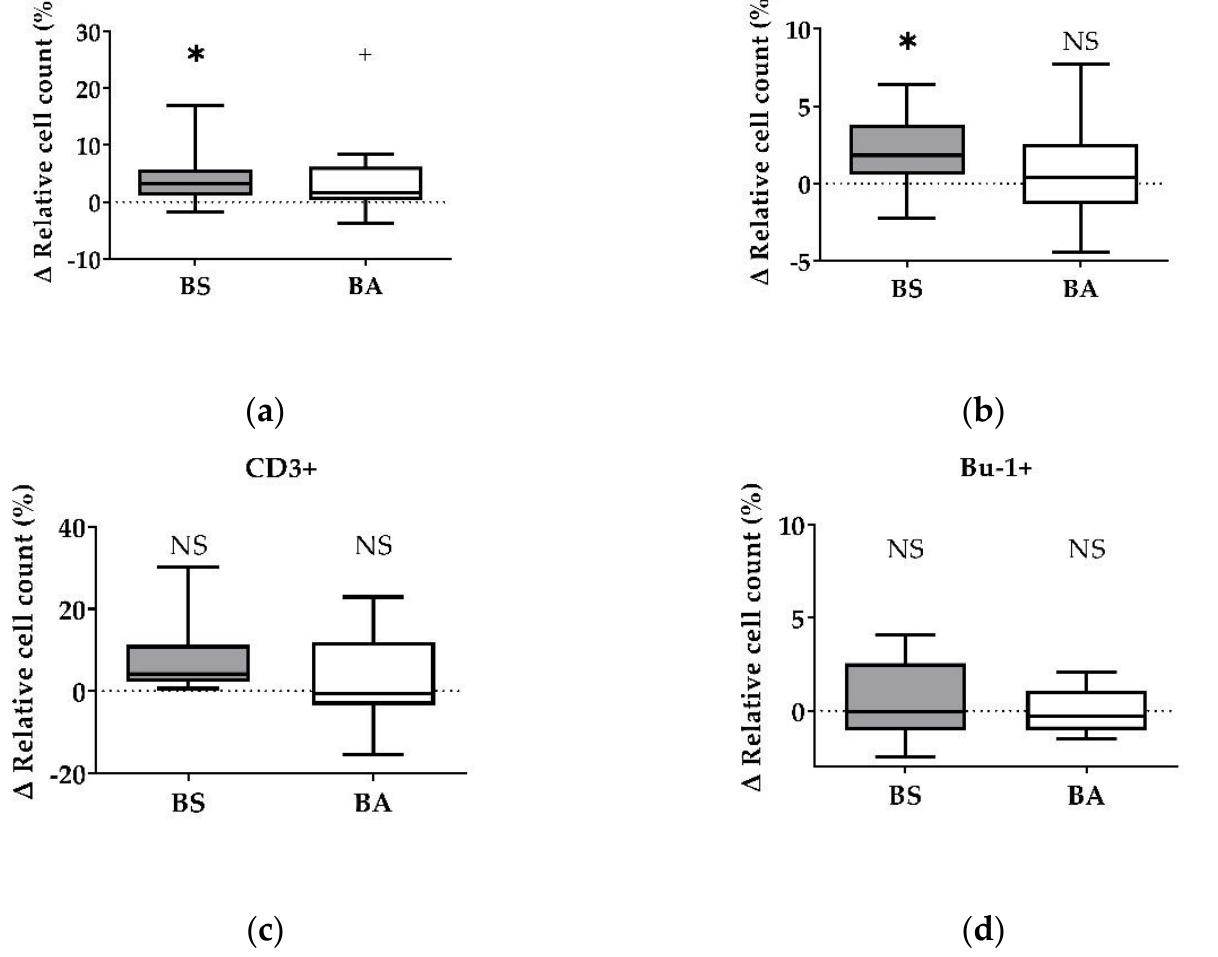
Figure 1. Influence of vital B. subtilis DSM 32315 (grey) and B. amyloliquefaciens CECT 5940 (white) on the proliferation of T and B cells. Isolated PBMCs were treated with BS or BA in a ratio of 1:3 (PBMCs: Bacillus ) or left untreated (negative control). After treatment for 24 h, immune cells were stained with monoclonal antibodies. The relative cell count was related to untreated controls. DAPI was used as a viability marker. ( a ) CD4+ T-helper cells, ( b ) CD8+ cytotoxic T cells, ( c ) all CD3+ T cells, and ( d ) Bu-1+ B cells relative to the vital PBMC cell count. 20,000 vital PBMCs were recorded